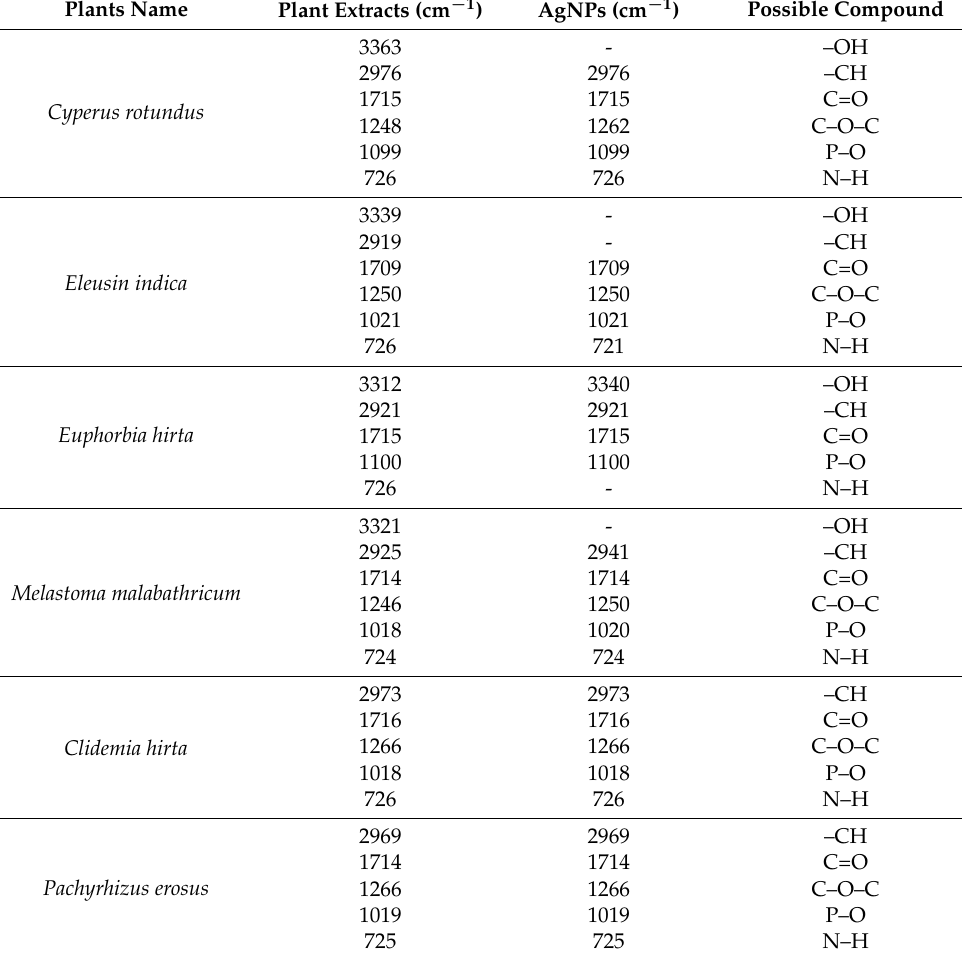
Table 2. Possible compounds of AgNPs synthesized using different plant